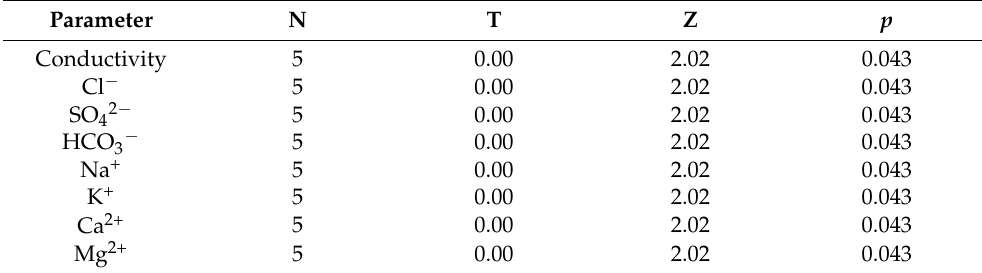
Table 3. Differences in the chemical composition of waters between the Por˛ebianka and Mszanka rivers (Wilcoxon test). Only significant differences are given.